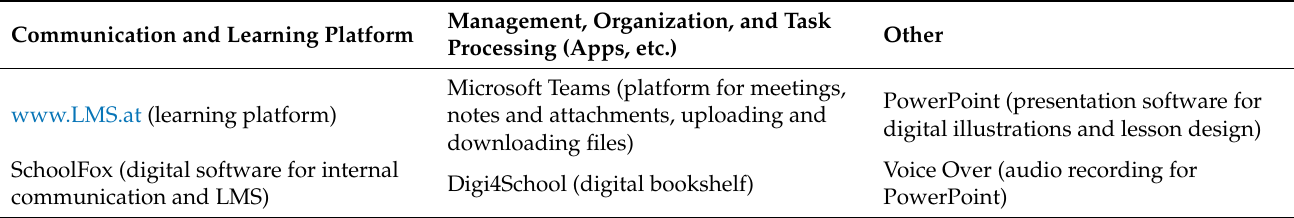
Table 3. Digital tools during Inclusive